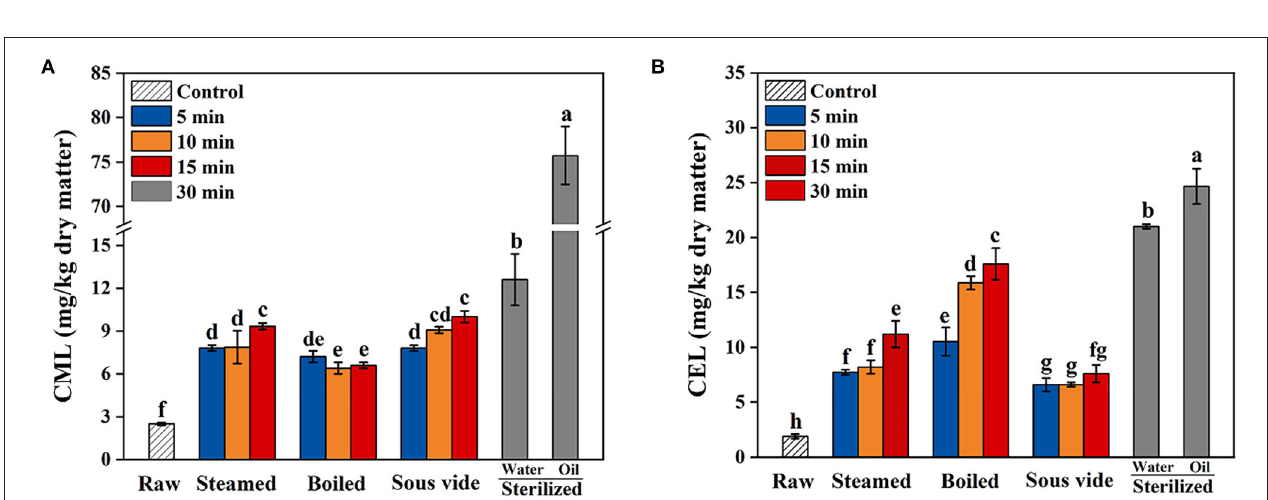
FIGURE 4 | Effects of steamed, boiled, sous vide, and sterilized treatments on the levels of (A) N ε -carboxymethyl-lysine (CML) and (B) N ε -carboxyethyl-lysine (CEL) in raw and processed oysters. Error bars indicate standard deviation ( n = 3). Samples designated with different lowercase letters were significantly different ( p < 0.05).